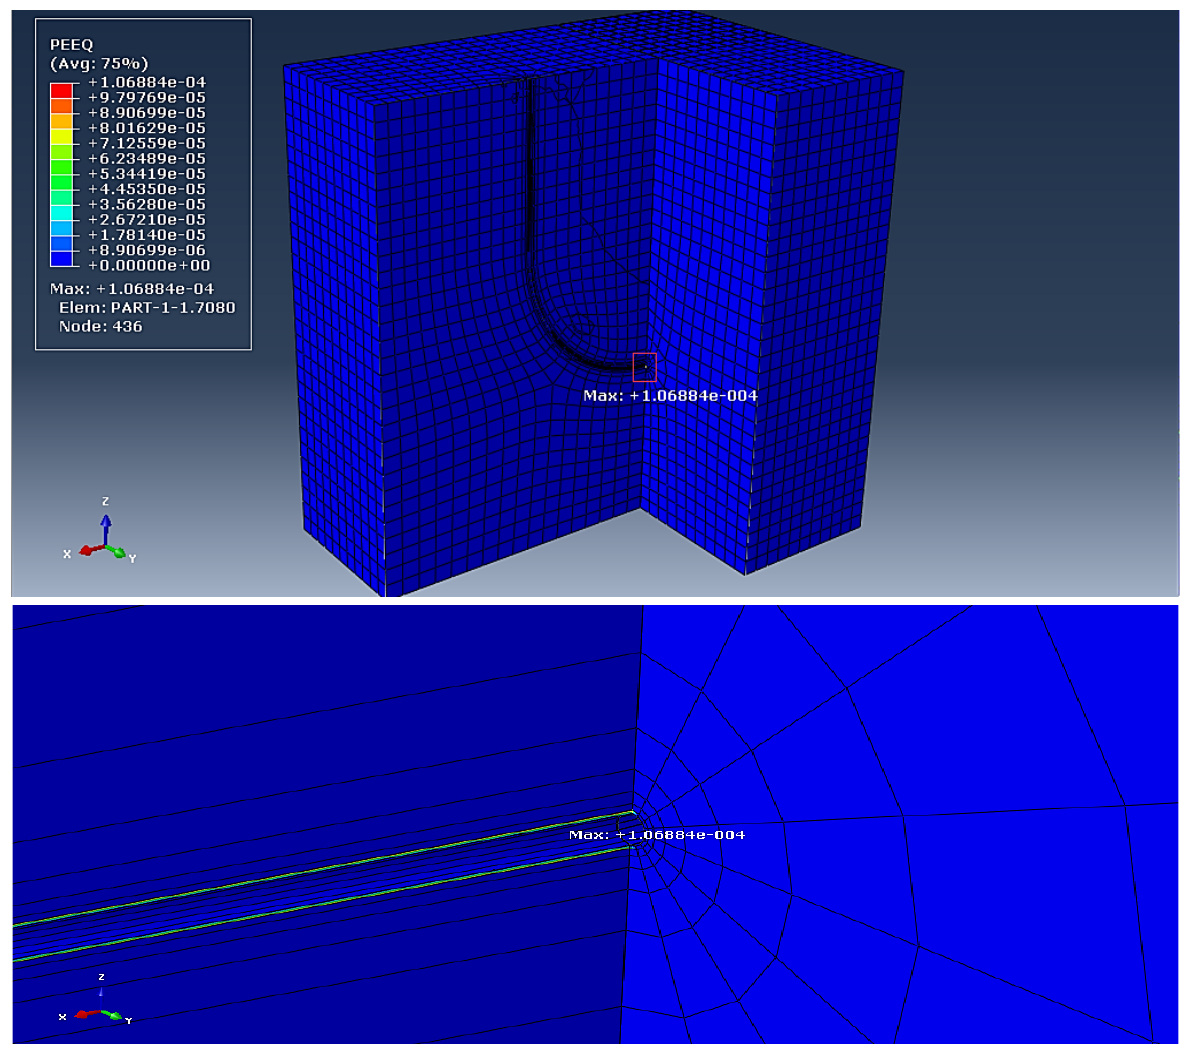
Figure 20. The azimuth of drilling direction in minimum horizontal stress, considering mud pressure less than the mud weight window.